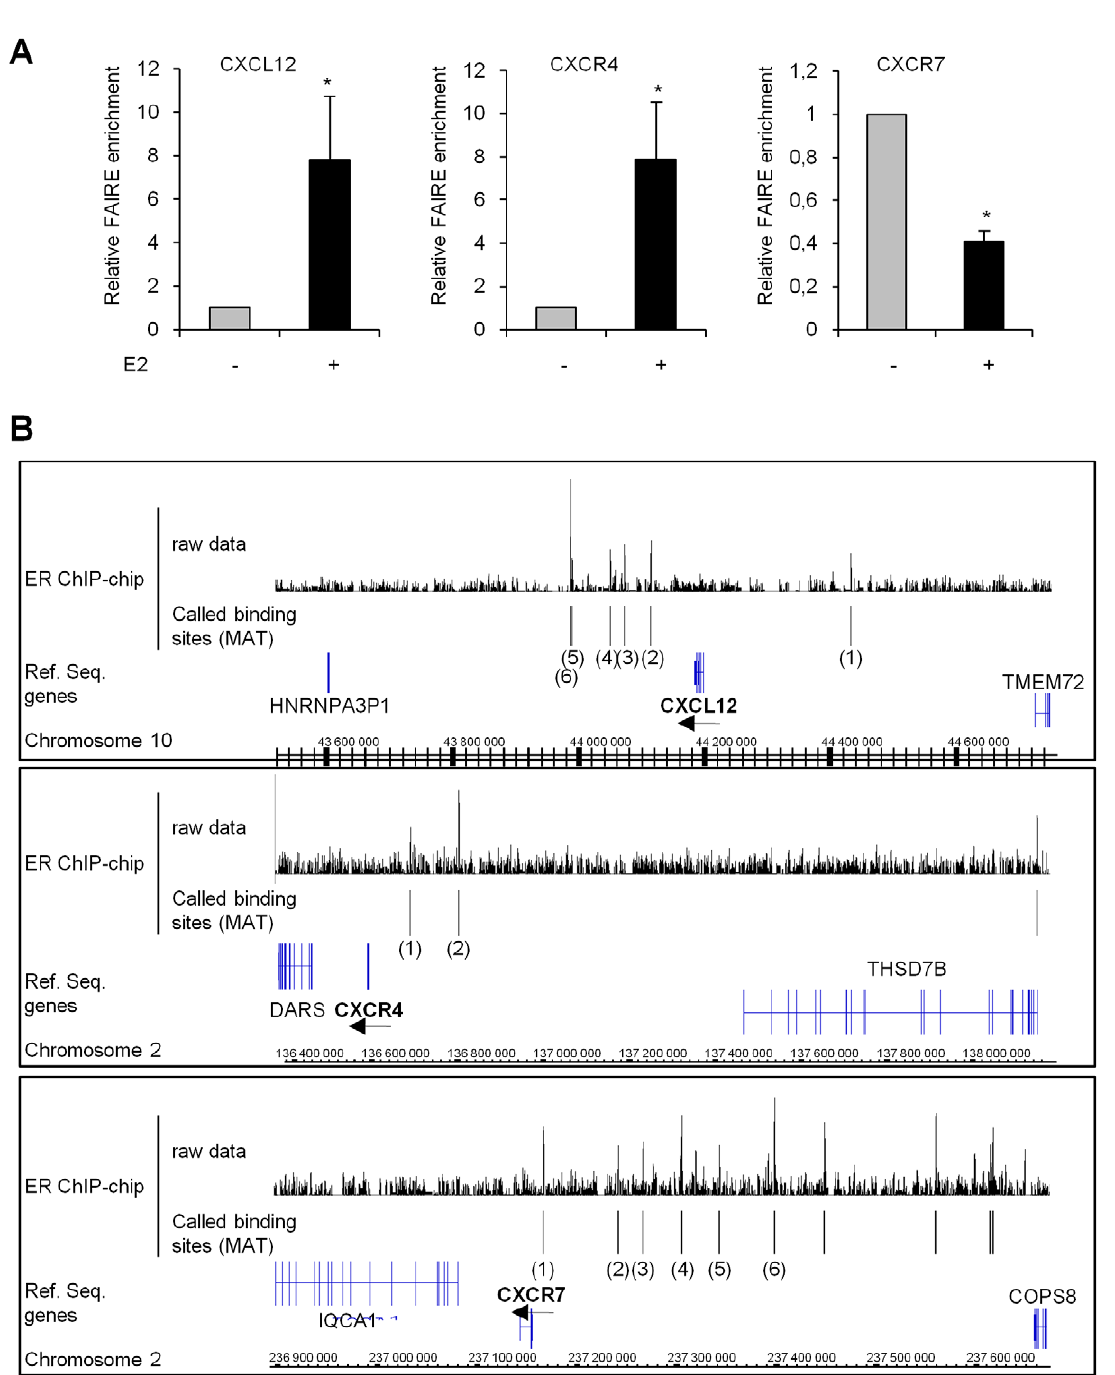
Figure 4. Impact of E2 treatment on the chromatin structure of the CXCL12 , CXCR4 and CXCR7 promoters. (A) FAIRE assays were performed on MCF-7 cells exposed to either ETOH ( 2 ) or 10 2 8 M E2 ( + ) for 48 h. Real-time PCR was performed to monitor enrichment of the DNA corresponding to the proximal promoters of the CXCL12 , CXCR4 and CXCR7 genes relative to input chromatin. The data are from triplicate samples and are representative of three separate experiments. Asterisks indicate significant differences ( p , 0.05) between the control and treated cells. (B) The Integrated Genome Browser (Affymetrix) was used to visualize ER-binding sites in the regions surrounding the CXCL12 , CXCR4 and CXCR7 genes. Raw ChIP-chip data for ER and high confidence ER-binding sites called using the MAT algorithm are shown [34,55]. The numbered ER-binding sites correspond to bound regions in which the closest TSS is that of CXCL12 , CXCR4 or CXCR7 . Arrows indicate the orientation of the CXCL12 , CXCR4 and CXCR7 genes.